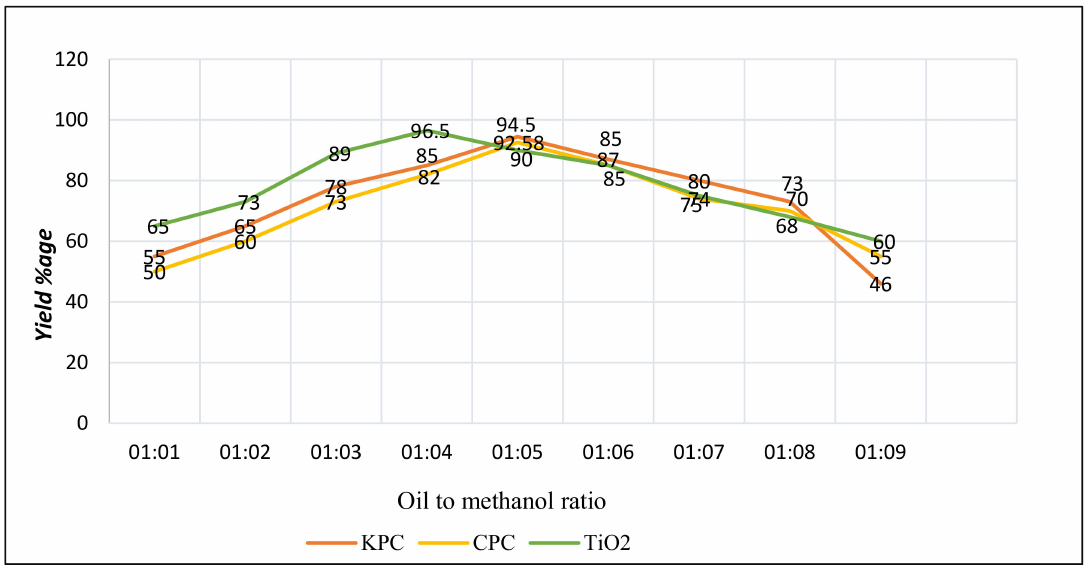
Figure 24. Oil-to-methanol ratio effect on transesterification, using 3 different types of catalysts while other variables were kept